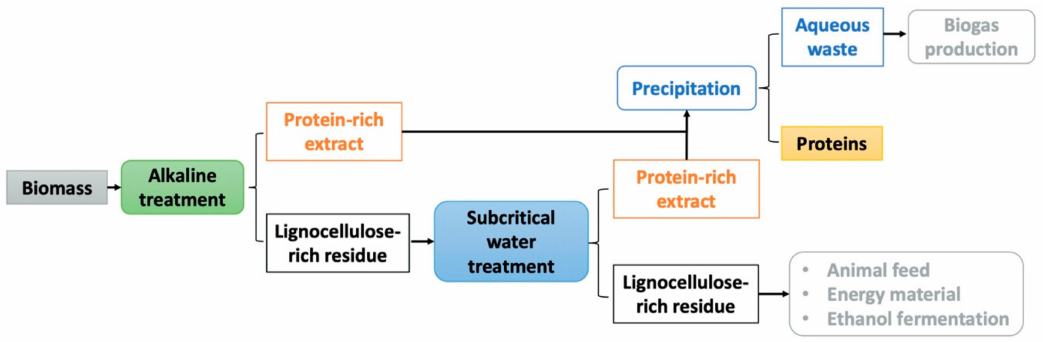
Figure 6. Integration of alkaline and subcritical water treatment to optimize protein extraction from